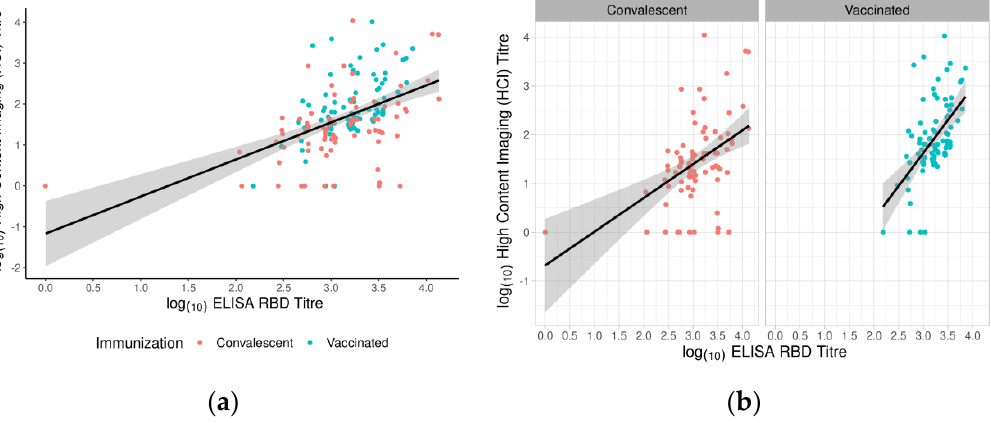
Figure 10. Anti-RBD IgG antibodies in human sera and their correlation with neutralising titre. ( a ) Log10 transformed values of titres obtained from ELISA RBD and NT 50 determined by HCI. ( b ) Correlation between anti-RBD IgG and neutralising antibody levels in convalescent subjects and vaccinated subjects. Di ff erent colour points indicate convalescent (red) and vaccinated (blue) participants. The best- fi t linear regression line with the corresponding con fi dence interval is presented as a black line with a grey band.